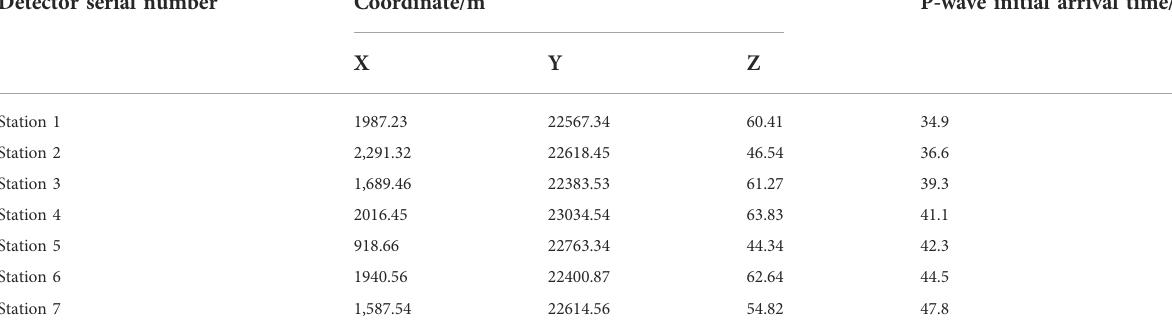
TABLE 4 Geophone coordinates and fi rst arrival-time of the P-waves. Detector serial